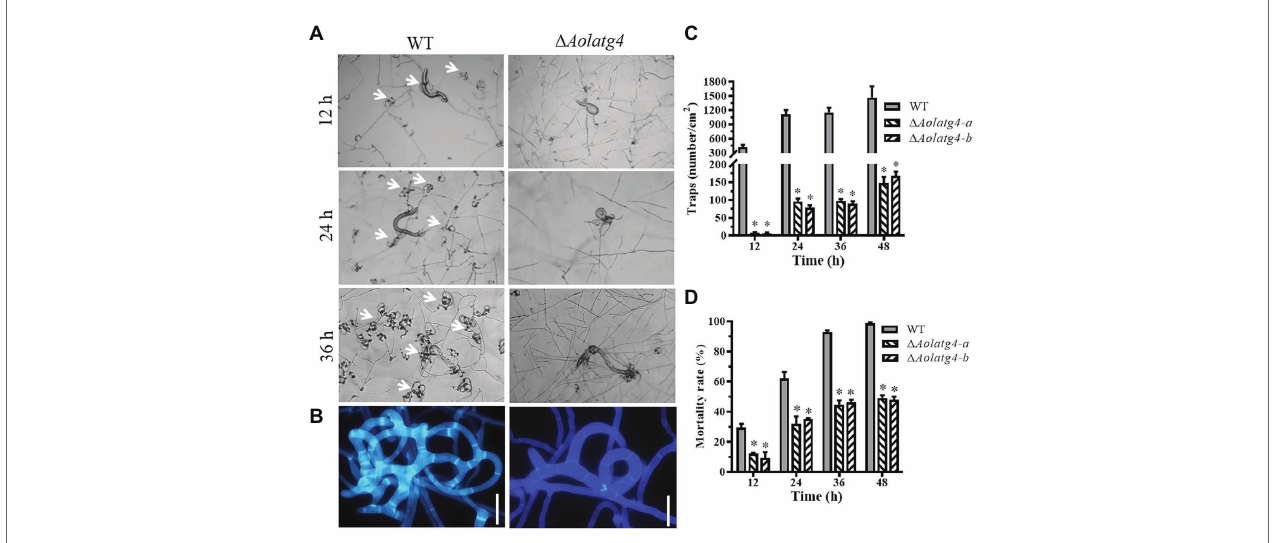
FIGURE 6 | Analysis of trap formation and nematicidal activity of the WT and Δ Aolatg4 mutants. (A) Traps induced by nematodes in WT and mutants at 12, 24, and 36 h. White arrow: traps. (B) The enlarged traps produced by the WT and mutants at 48 h; the traps were stained with Calcofluor White (CFW; 10 μ g/ml). Scale bars = 10 μ m. (C) The traps produced by the WT and mutants at different time points. (D) The mortality rate (%) of nematodes at different time points. Each experiment was performed three times. Error bars: standard deviation, asterisk: significant difference between mutant and WT (Tukey’s HSD, p <